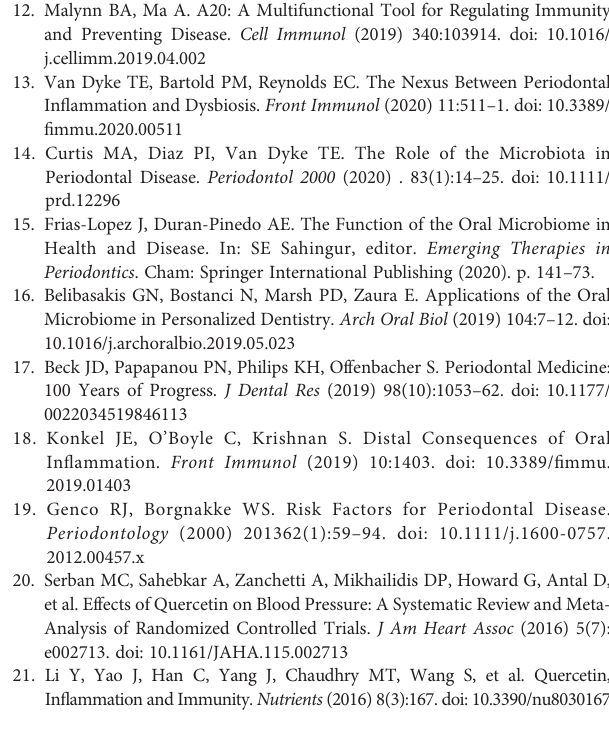
Supplementary Figure 1 | Quercetin Treatment Alters Oral Microbial Composition Induced by Periodontitis. Signi fi cantly altered taxa in Quercetin treated compared to vehicle treated mice after periodontitis onset (Day 13) as determined by linear discriminant analysis effect size (LDA) scores using HOMD 16S rRNA database. Supplementary Figure 2 | Quercetin diminishes cytokine production in human macrophages challenged with oral bacteria and toll-like receptor agonists. THP-1 macrophages treated with Quercetin (5µg/mL) or vehicle matched control were infectedwithoralbacteriaortoll-likereceptoragonistsforup to12hours. (A – E) IL-6 and TNF levels in the supernatants were determined with ELISA. ELISA was conducted on (A) macrophages infected with P. gingivalis (100 MOI), (B) macrophages infected with F. nucleatum (50 MOI), (C) macrophages infected with P. gingivalis LPS (10µg/mL), (D) macrophages infected with Pam3CSK4 (10ng/mL) and (E) macrophages infected with ODN 2006 (100µg/mL). Each experiment was performed three times independently and averages and standard deviations are shown. ****p<0.0001. ####Unstimulated control cells versus corresponding stimulated cells (p<0.0001). #Unstimulated control cells versus corresponding stimulated cells